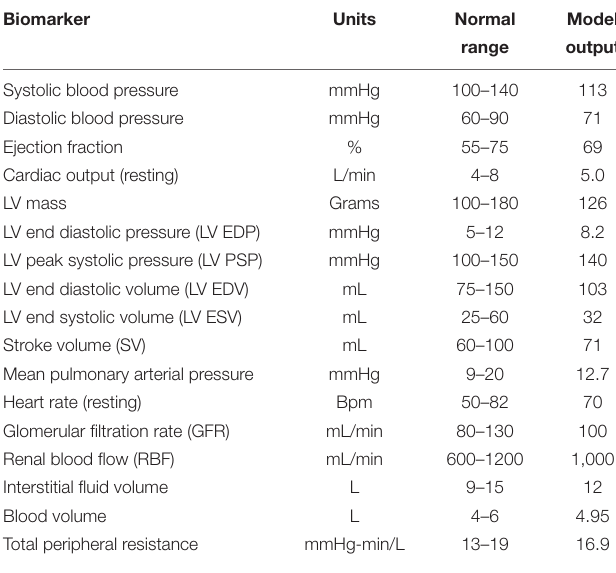
TABLE 2 | Key model variables at baseline fall within the physiologically normal